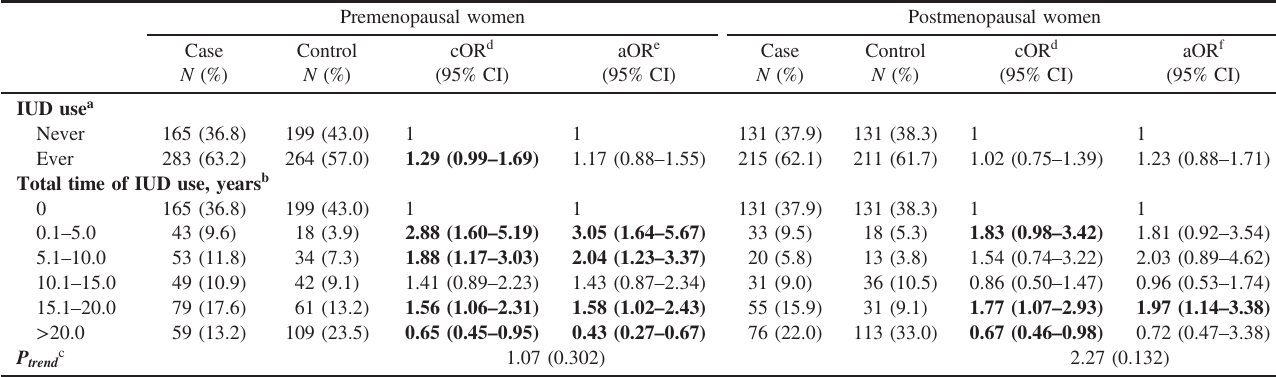
Table 3. Correlation between IUD use and breast cancer risk